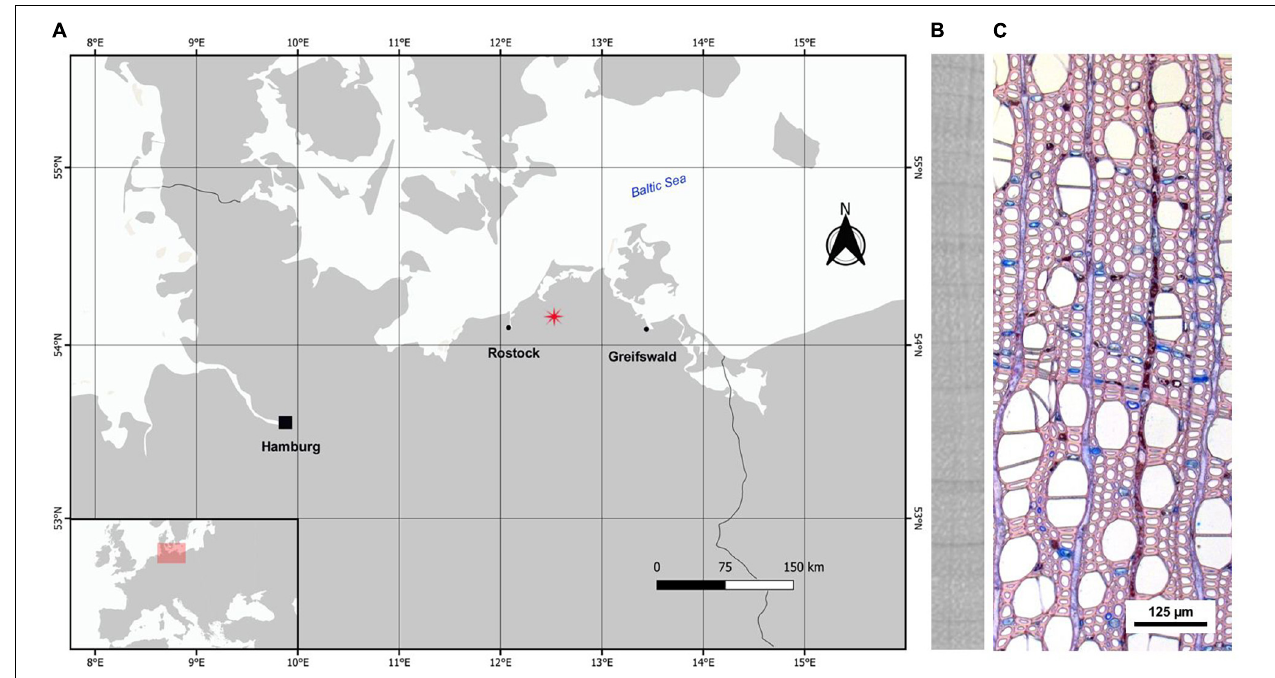
FIGURE 1 | (A) Study area in NE Germany, (B) x-radiography of alder wood, (C) thin section of alder stem for xylem anatomical analysis. Vessels, fibers, ray and axial parenchyma, and a ring boundary (in the middle) are visible in the section, which belongs to tree ADAG01 from the drained stand.